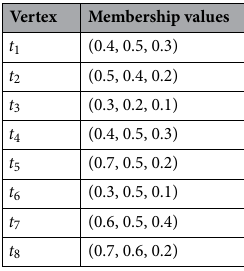
Table 1. Vertex membership values of